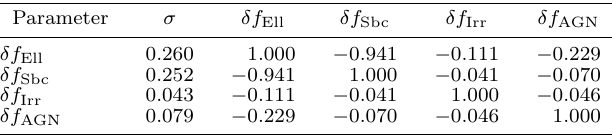
Table 4 Covariance Matrix of All SED Templates